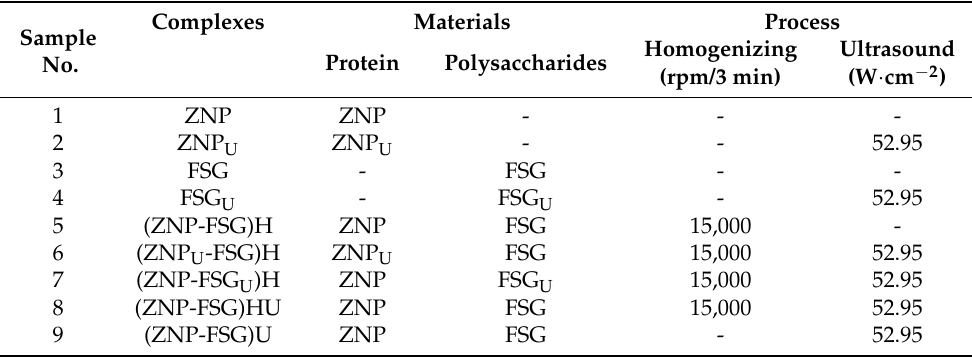
Table 1. The process of complex particles